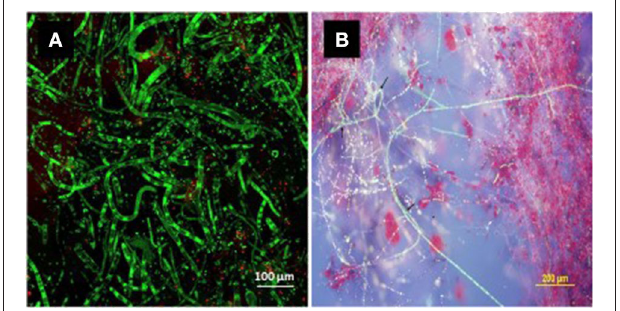
FIGURE 1 | Bright green fluorescing hyphae of Neopseudocercosporella capsellae (isolate UWA Wlra-7) on malt extract agar detected by confocal microscopy. The green fluorescence confirms the cercosporin inside the hyphae in a chemically reduced state protecting the pathogen from its toxicity (Daub et al., 2000; Chung et al., 2002) [ (A) cercosporin producing hyphae and, (B) cercosporin producing hyphae and secreted red cercosporin crystals among green